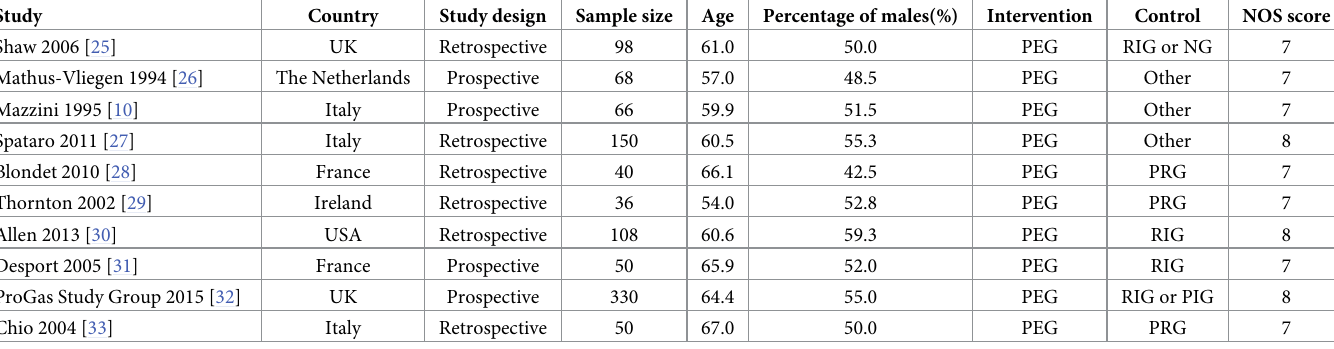
Table 1. Baseline characteristic of studies included in the systematic review and meta-analysis.